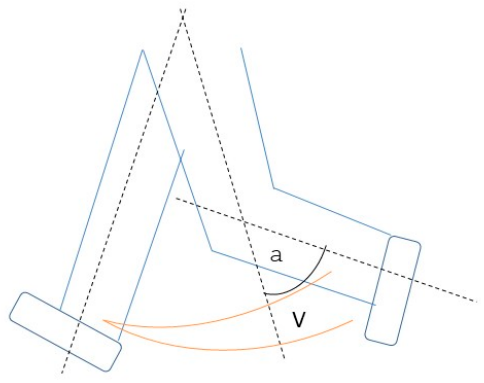
Figure 3. schematic principle of sonification version Soni 1.1 with V = Volume (increasing with increasement of a = knee angle (knee angle (a) is 180°-between-segment-angle ( α )).